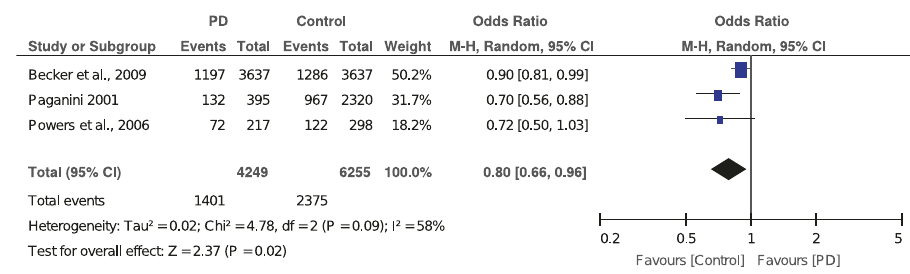
Fig. 2 Forest plot of pooled analysis for matched case-control studies on the association of hypertension with risk of Parkinson ’ s disease. Individual and overall ORs and the corresponding 95% CIs are reported. The size of the box is proportional to the weight assigned to each study, and the horizontal lines represent the 95%